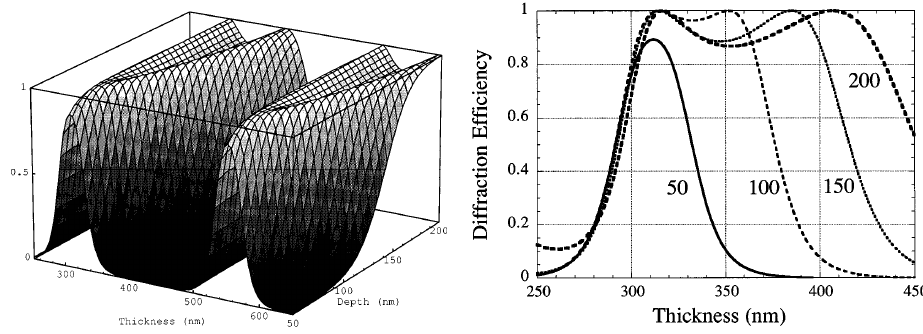
Figure 5. Theoretical diffraction efficiency.